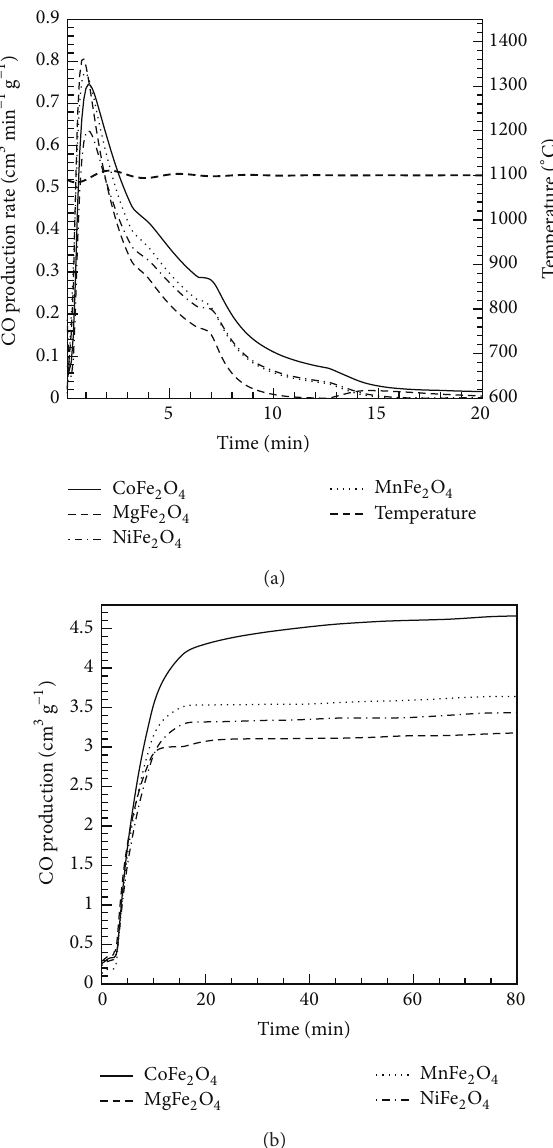
Figure 10: CO production (a) rate and (b) yield of all samples at the 5th